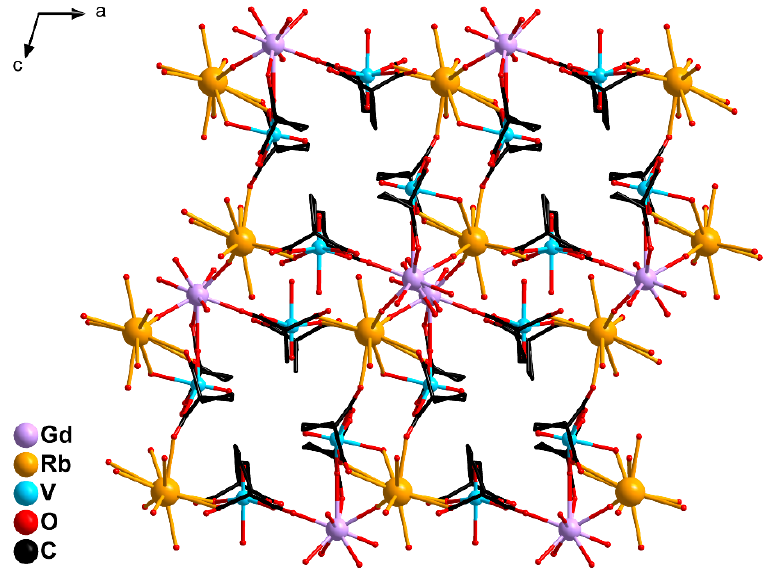
Figure 5. A fragment of 3D-polymeric structure of 2 : {GdV 2 } – units linked by Rb + cations (H atoms are not shown).